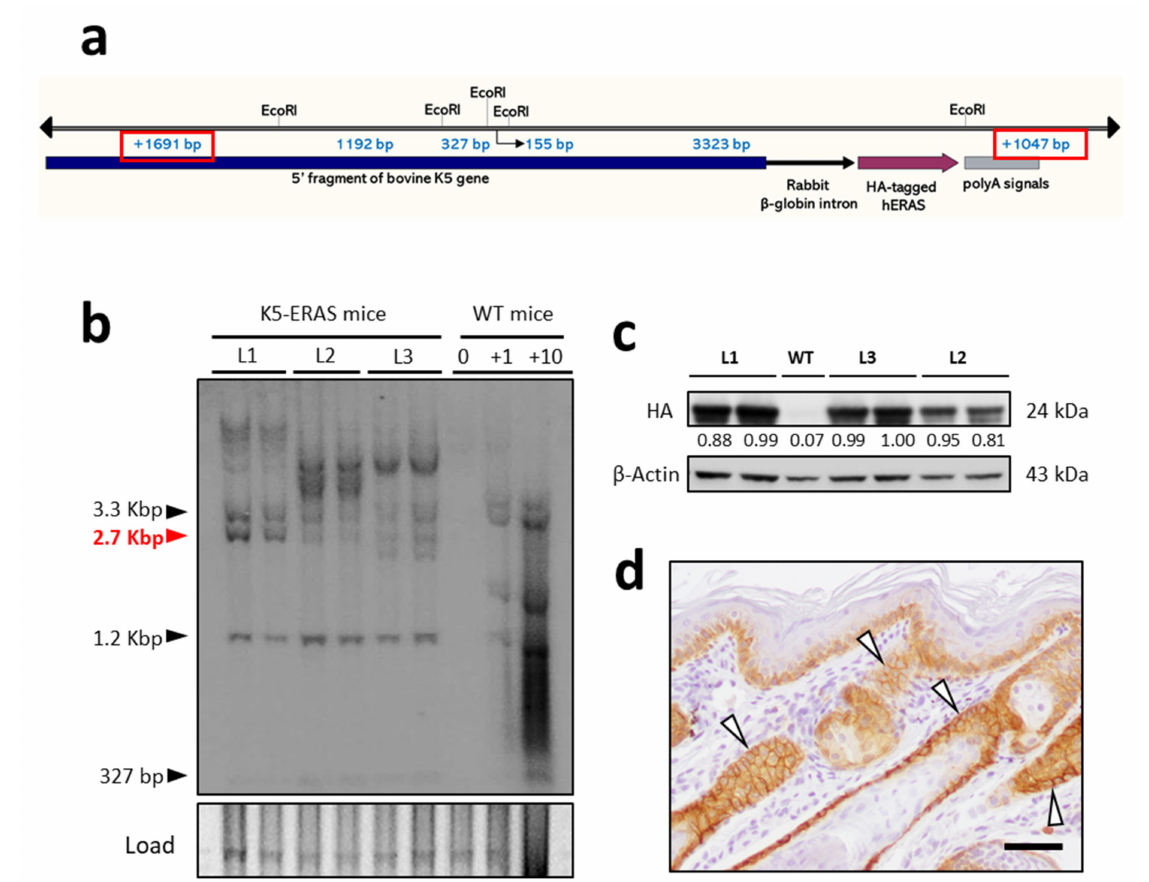
Figure 1. Genetic characterization and transgene expression in K5-ERAS lines. ( a ) Schematic representation of the K5-ERAS transgene structure. The location of EcoRI sites and the expected fragments in a Southern blot analysis are shown. The junction of 5 (cid:48) - and 3 (cid:48) -terminal fragments (sizes framed in red) would result in a fragment of approximately 2.7 Kbp in the case of head-to-tail tandem insertion. ( b ) Southern blot analysis of EcoRI-digested tail DNA from two mice of each line—L1, L2 and L3—and from WT mice (lane marked 0) and WT mice with the addition of the K5-ERAS plasmid insert used to obtain the transgenic mice in amounts corresponding to 1 or 10 copies per diploid genome (lanes marked +1 and +10). The approximate mobility of each band is indicated on the left; the 2.7 Kbp band resulting from head-to-tail junctions between adjacent copies is indicated in red. As a loading control, the prominent 1.3 Kbp fragment observed in the ethidium bromide staining of the EcoRI-digested mouse DNA is shown. ( c ) Western blot analysis of ERAS expression in tail skin of transgenic mice. An antibody recognizing the HA epitope was used. β -Actin was used as a loading control. ( d ) Immunohistochemical staining of tail skin of a K5-ERAS transgenic mouse with an antibody recognizing the HA epitope. ERAS expression is detected in epidermal basal cells and in the outer root sheath of hair follicles, mimicking the expression pattern at the cellular level of keratin K5. Note that the staining is stronger in the cell membrane, which is suggestive of the functionality of transgenic ERAS. Bar: 50 µ